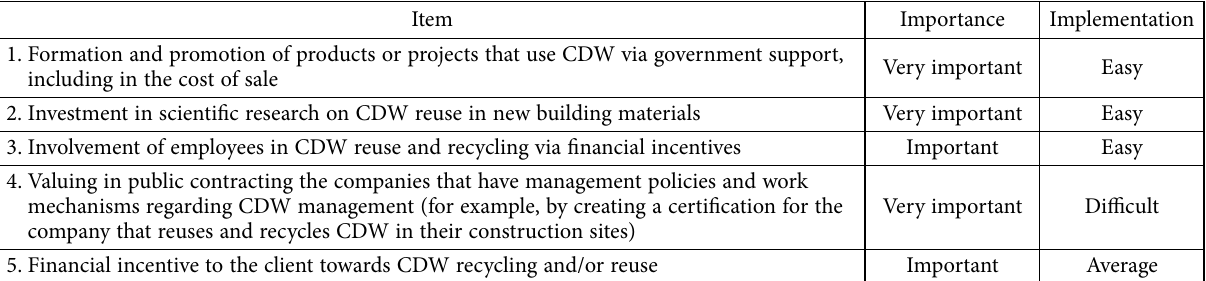
Table 11. Factors that prove the practice of CDW reuse and recycling in Portugal